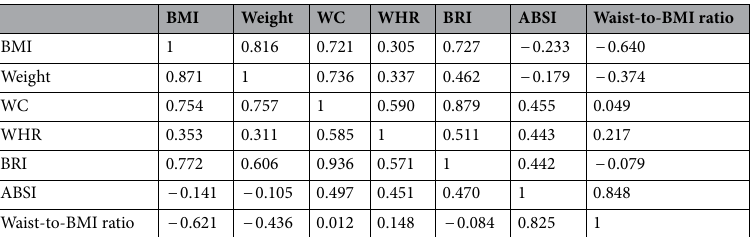
Model with categorical BMI (Sample size after imputation n = 6920)